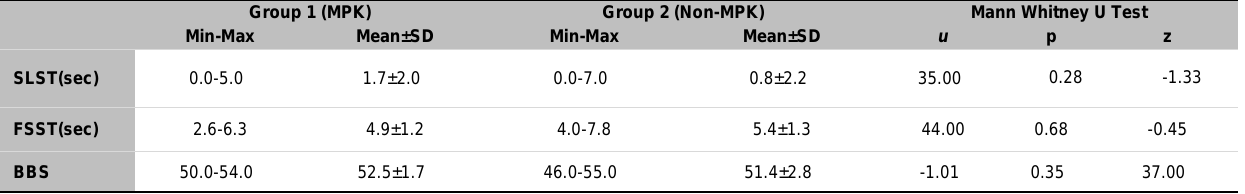
Table 3: Comparison of the balance parameters of two